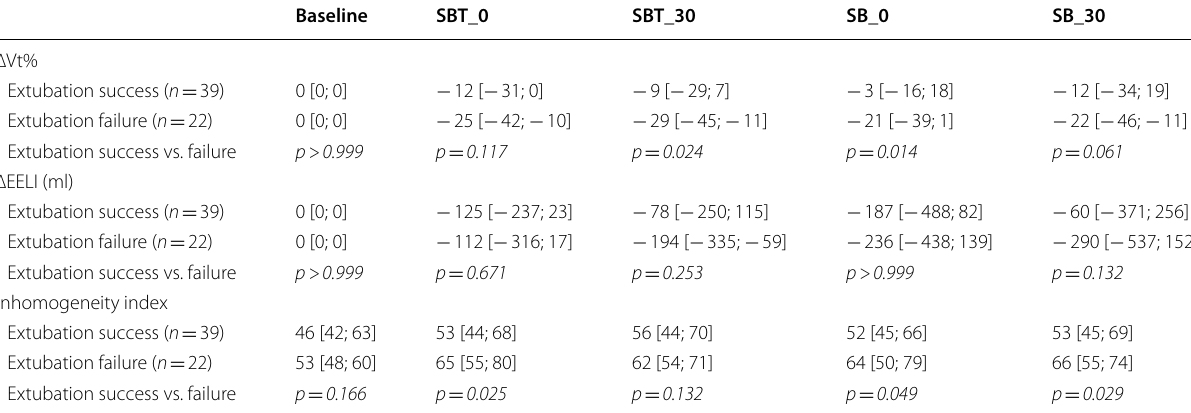
SBT: Spontaneous Breathing Trial; SBT_0: first 5 min after the beginning of the SBT; SBT_30: last 5 min of the SBT; SB_0: first 5 min of the spontaneous breathing; SB_30: last 5 min of the spontaneous breathing; ∆Vt%: change from baseline of the tidal volume in percentage; ∆EELI: change from baseline of the end-expiratory lung impedance According to Bonferroni correction, the threshold for statistical significance is p <